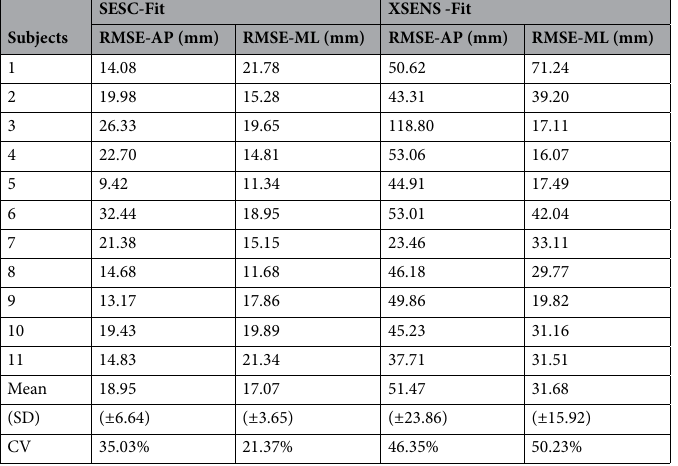
Table 1. The RMSEs of the CoM estimations based on SESC and segmental (XSENS) method for 11 Fit subjects along AP and ML axes. The mean and standard deviation (SD) values of the RMSEs of the subjects and the coefficients of variation (CV) are provided in the last three